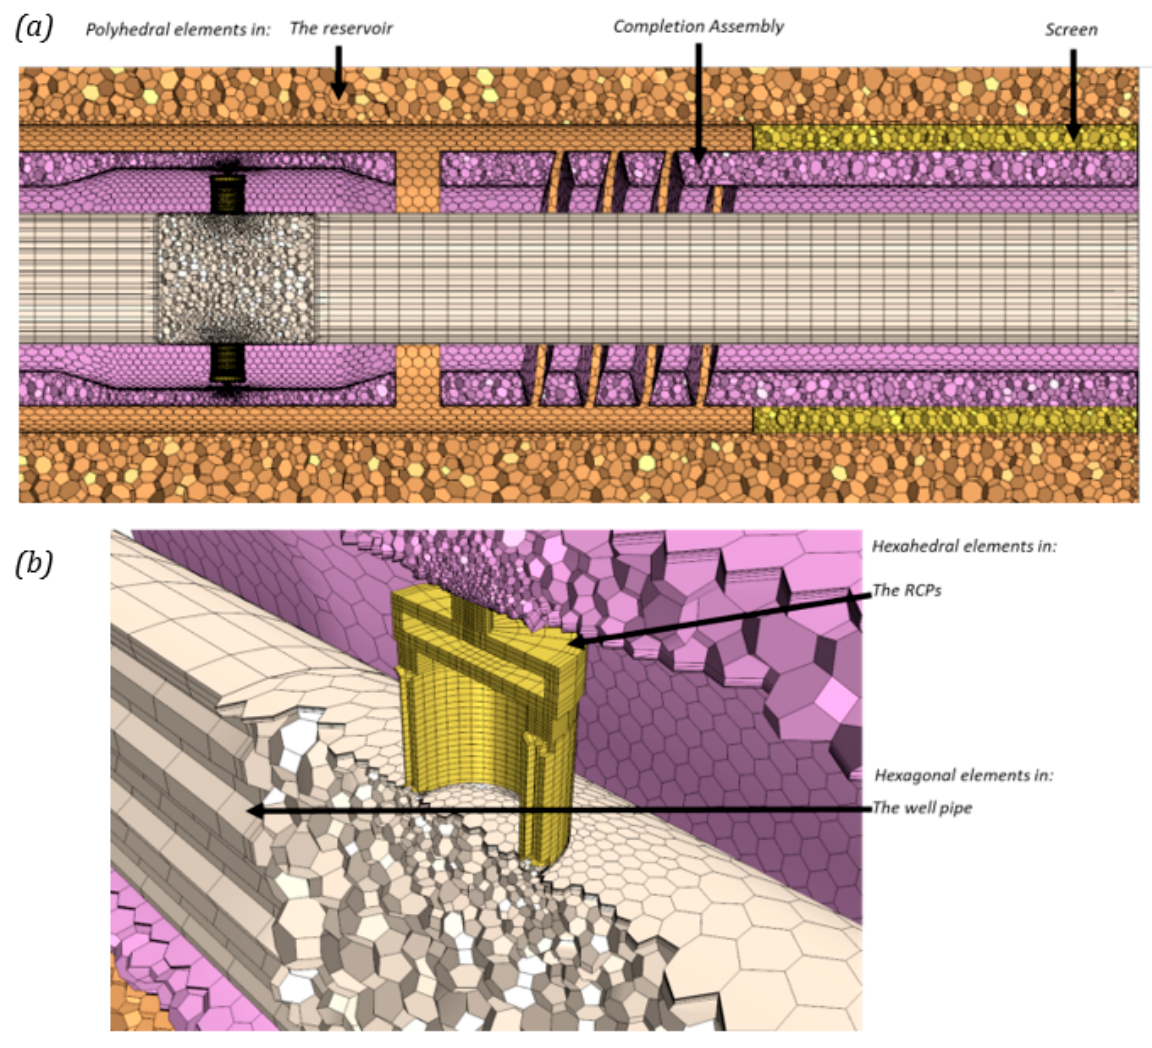
Figure 4. General view of the mesh used on the complete AICD assembly modeling: ( a ) General view and ( b ) the detailed view at the top RCP valve. Table 3. The number of elements implemented in the spatial discretization of the different RCP completion models.